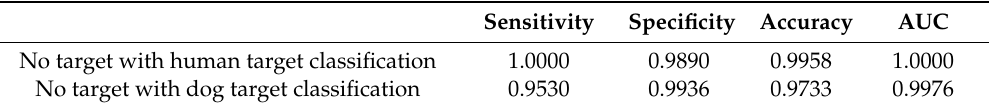
human targets and dog targets, respectively.